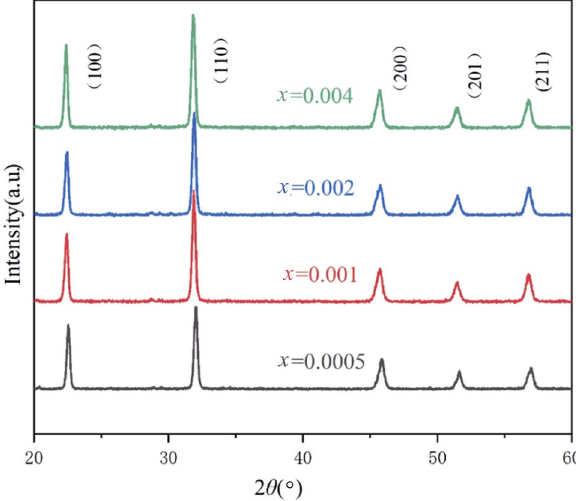
Fig. 3 XRD patterns of KNNS–0.04BNKZ– x Sm ( x = 0.0005, 0.001, 0.002, and 0.004)